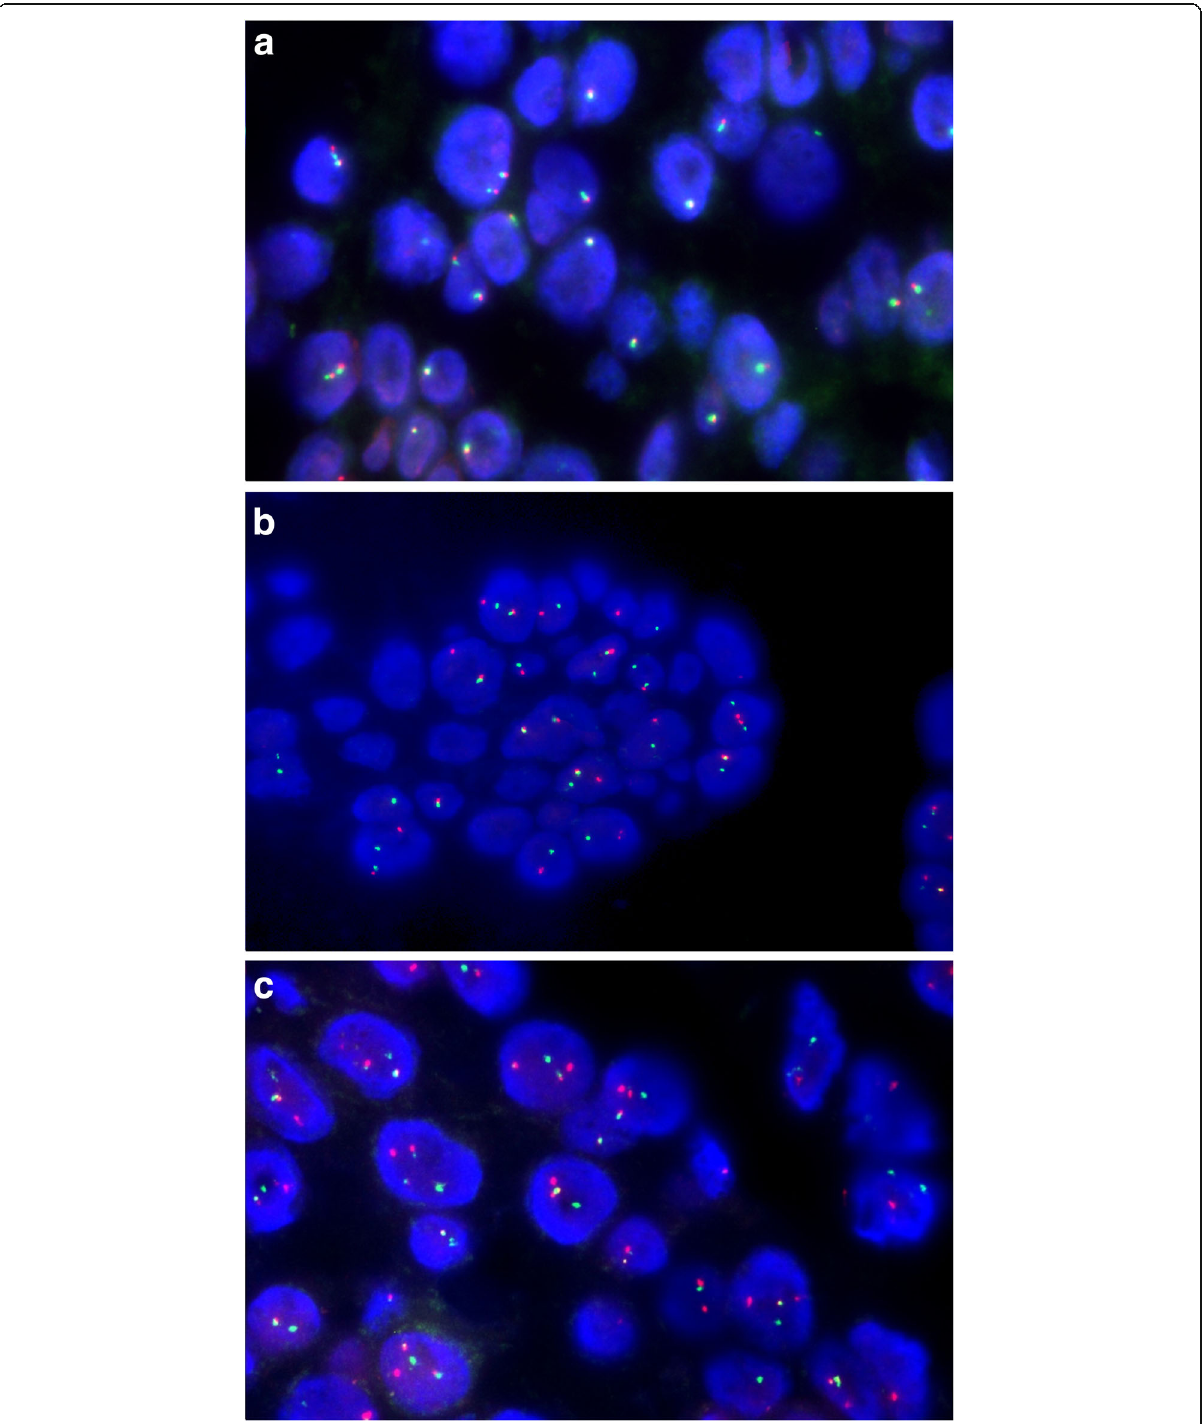
Fig. 3 A Fluorescence in situ hybridization (FISH) was negative for MAML2 rearrangement (the MAML2 locus is rearranged in 2% of neoplastic cells as characterized by one green, one red, and one fusion signal). B Fluorescence in situ hybridization (FISH) was positive for EWSR1 gene rearrangement (the EWSR1 locus is rearranged in 25% of neoplastic cells as characterized by one green, one red, and one fusion signal). C Fluorescence in situ hybridization (FISH) was positive for EWSR1-ATF1 fusion (EWSR1-ATF1 fusion in 32% of neoplastic cells as characterized by one green, one red, and two fusion